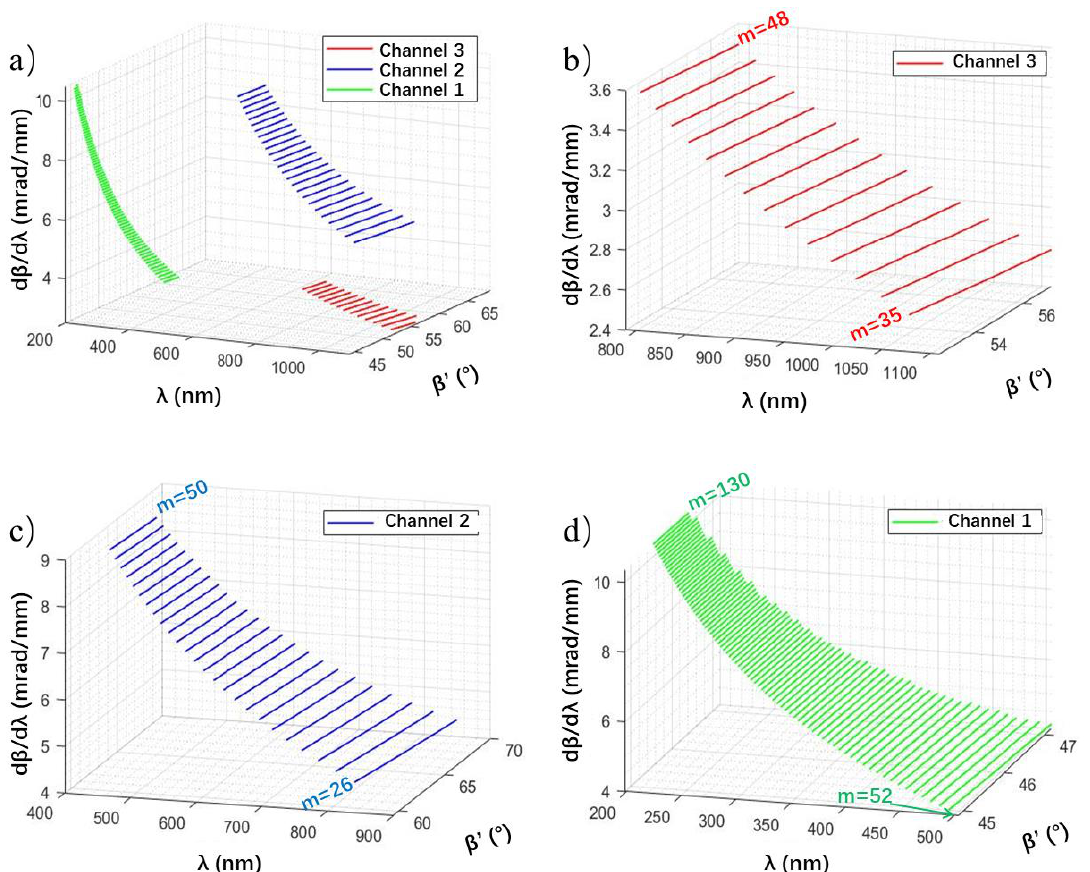
Figure 2. Wavelength – diffraction angle – angular dispersion relationship of the echelle gratings. ( a ) Schematic of the three channels, ( b ) channel 3, ( c ) channel 2, and ( d ) channel 1. dβ/dλ is the angular dispersion, β’ is the diffraction angle, m is the order.